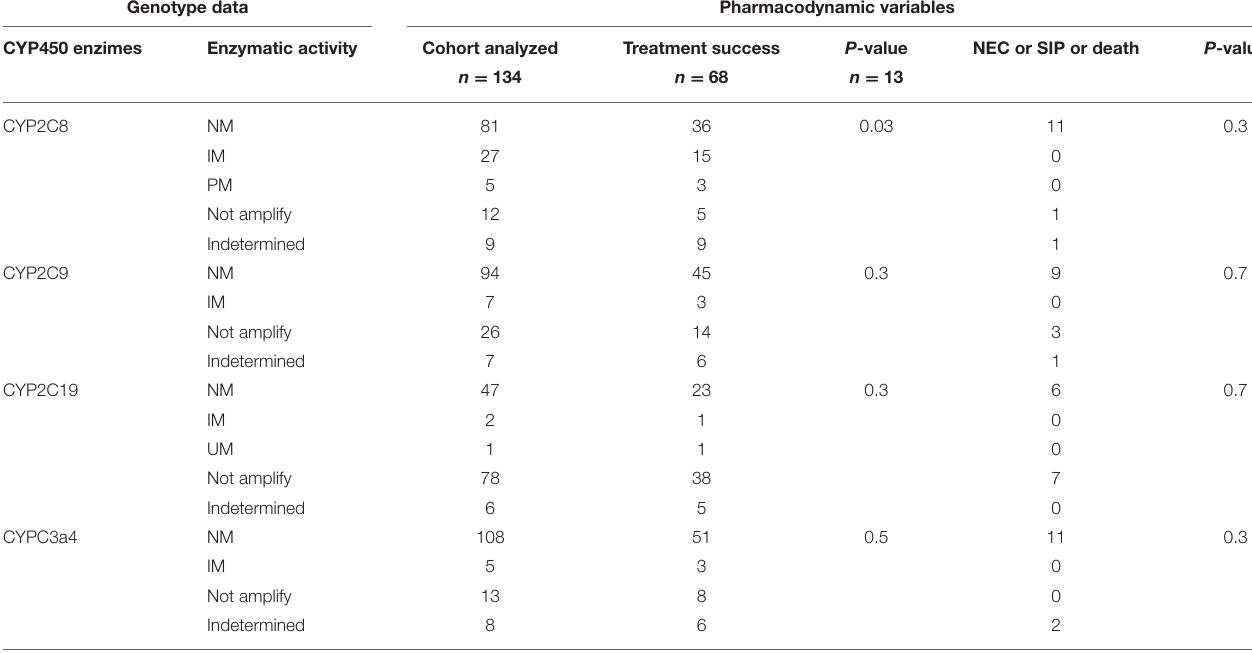
TABLE 5 | Effect of CYP450 genotypes on pharmacodynamics. Genotype